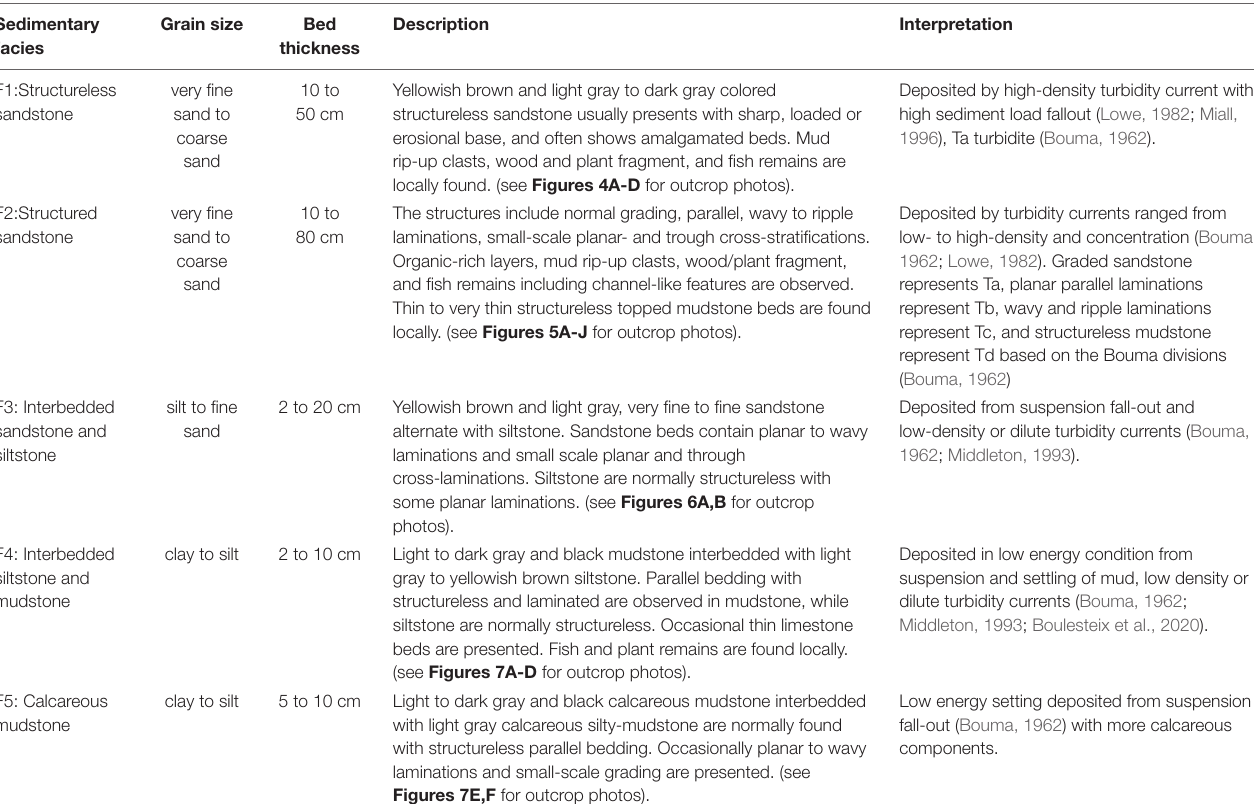
TABLE 1 | Summary of sedimentary facies from the studied